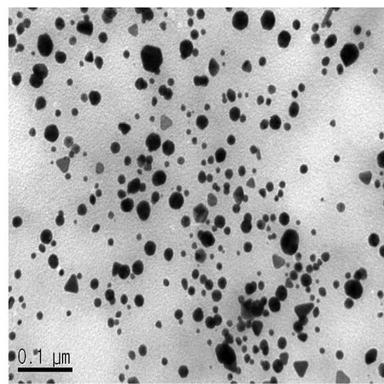
Transmission electron microscope image of AuNPs synthesized using Lonicera japonica flower extract.